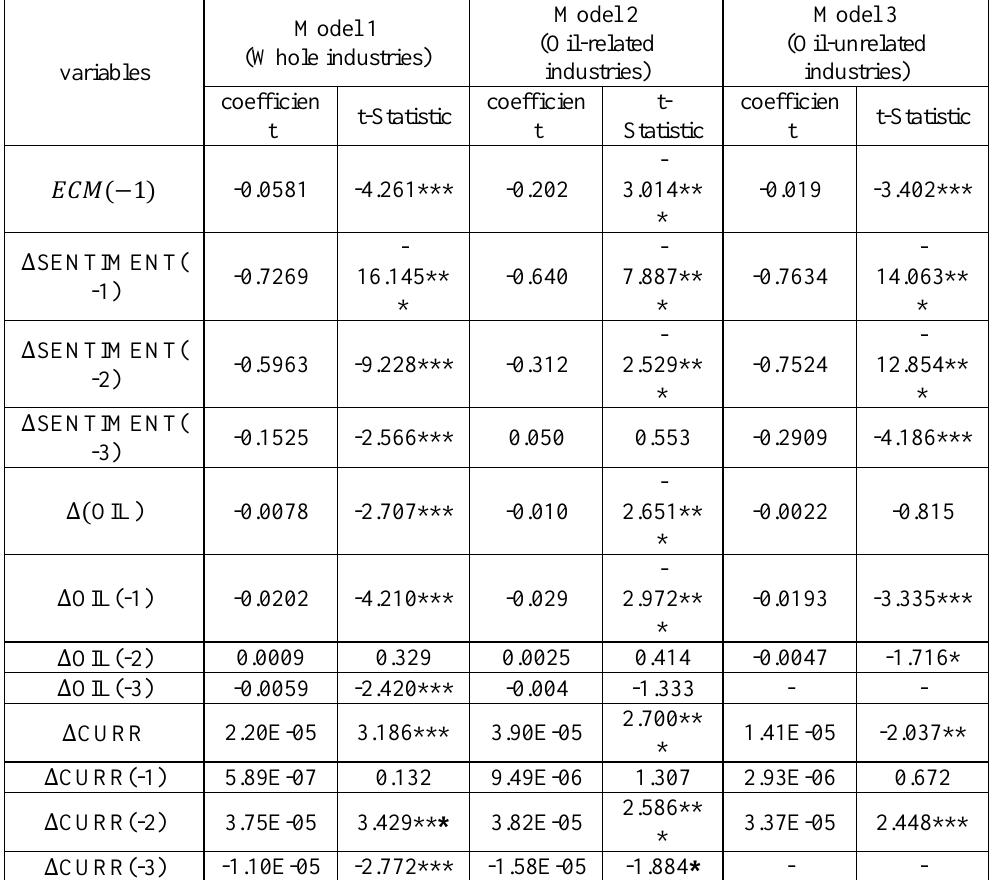
Table 6. PMG short-run